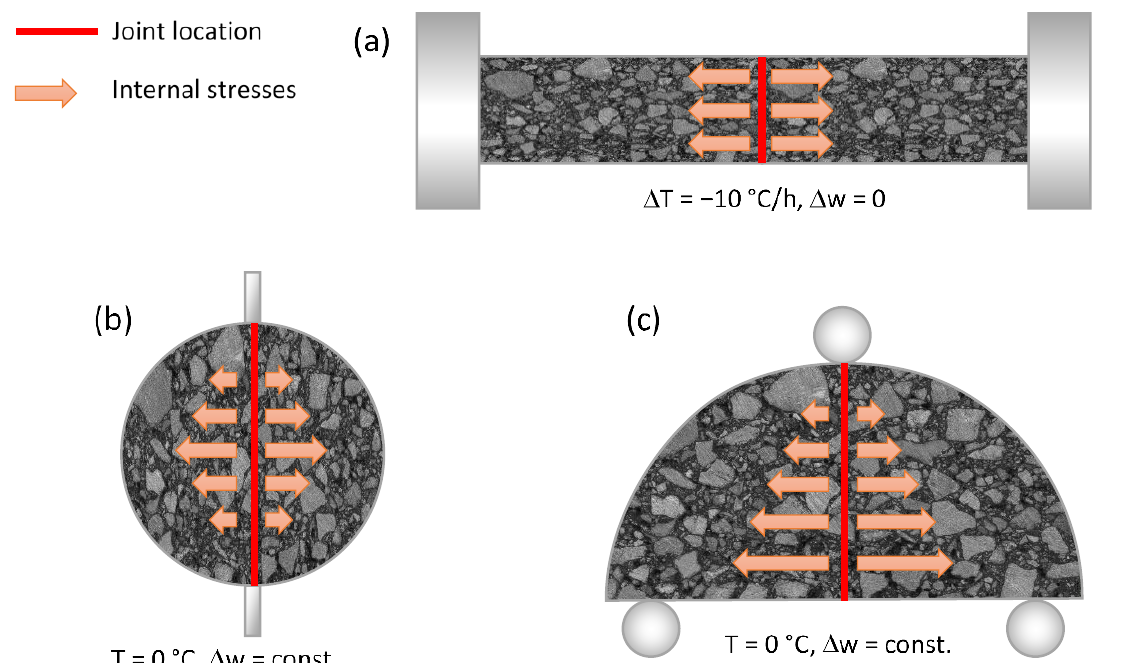
1 Figure 3. ( a ) Joint location in TSRST specimen (deflection rate − ∆ w = 0 mm/min); ( b ) Joint location in ITS specimen (deflection rate − ∆ w = 50 ± 2 mm/min); ( c ) Joint location in SCB specimen (deflection rate − ∆ w = 5 ± 0.2 mm/min). Figure 3. ( a ) Joint location in TSRST specimen ; ( b ) Joint location in ITS specimen ± 2 mm/min); ( c ) Joint location in SCB specimen ( = 5 ± 0.2 mm/min). Table 6. Description of testing methodology and